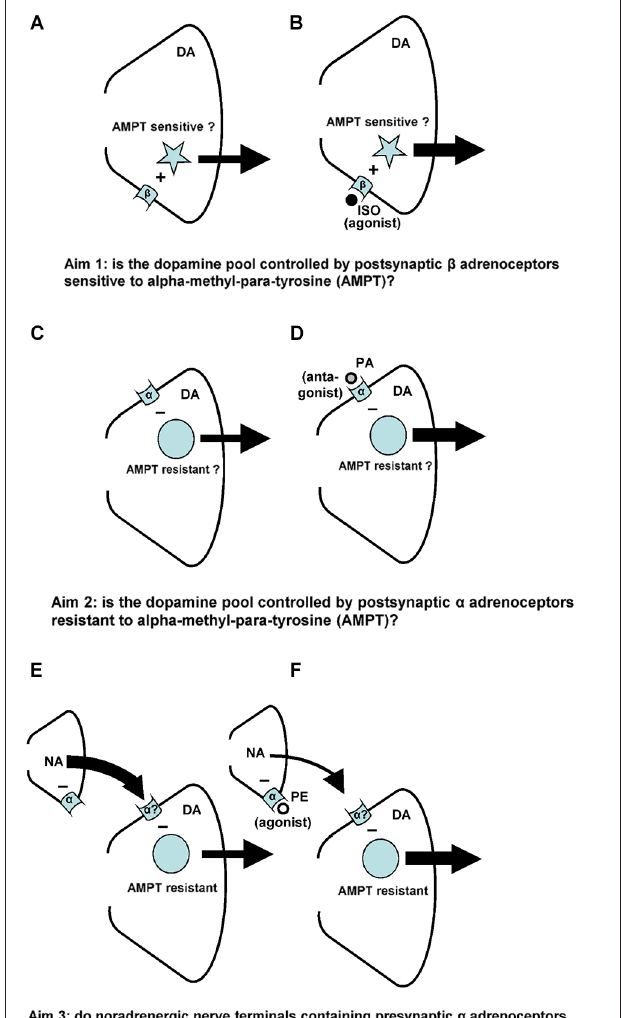
FIGURE 1 | Noradrenaline-(NA)-induced changes in accumbal DA release . Postsynaptic beta-( β )-adrenoceptors stimulate (+) the release of accumbal DA (A) , whereas postsynaptic alpha-( α )-adrenoceptors inhibit ( − ) the release of accumbal DA (C) . The first aim of the study was to investigate whether the postsynaptic acting beta-adrenoceptor agonist ISO increases DA release from AMPT sensitive pools of DA (B) . The second aim of the study was to investigate whether the postsynaptic acting alpha-adrenoceptor antagonist PA increases DA release from AMPT-resistant pools of DA (D) . Presynaptic alpha-( α )-adrenoceptors regulate accumbal NA levels (E) . The presynaptic acting alpha-adrenoceptor agonist PE is known to reduce accumbal NA release (F) . The third aim of this study was to investigate whether the noradrenergic neurons that contain presynaptic alpha-adrenoceptors impinge upon dopaminergic neurons that contain postsynaptic alpha-, but not beta-adrenoceptors (F)